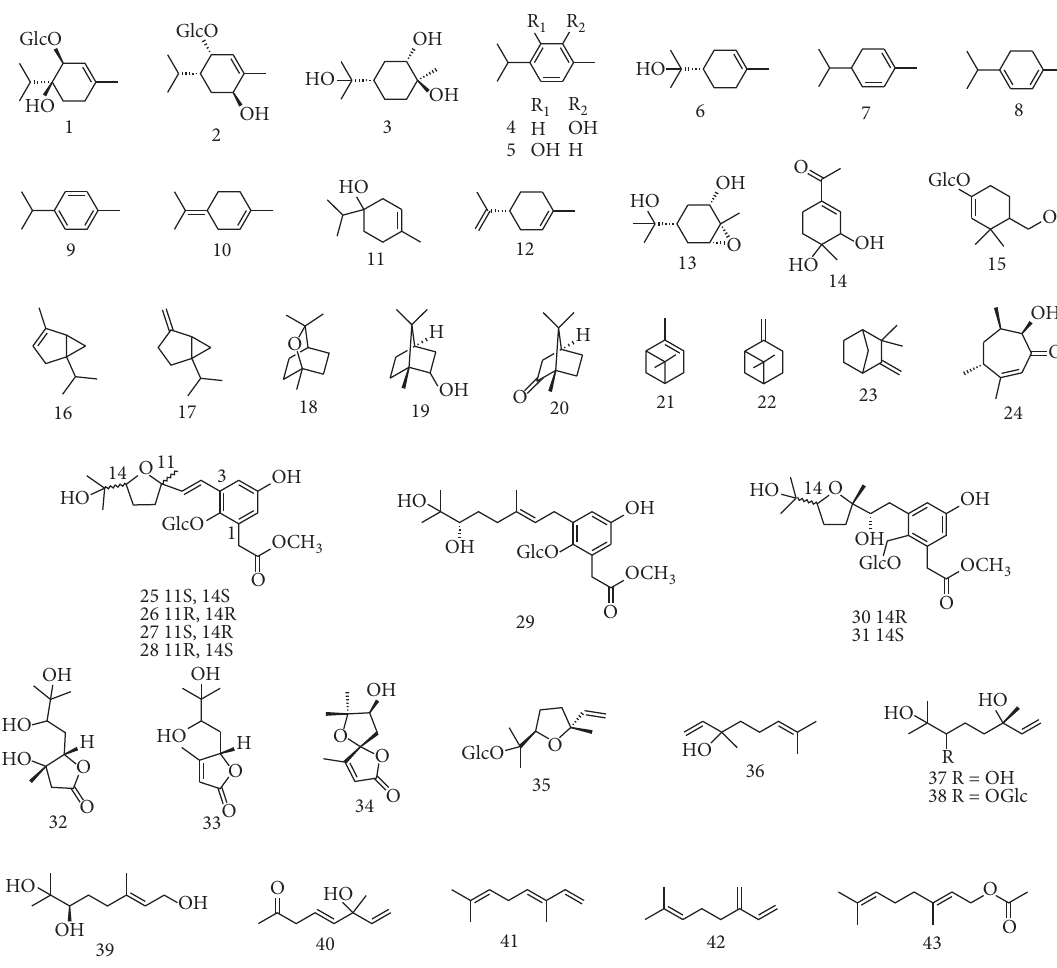
Figure 1: The structures of monoterpenes from Cinnamomum